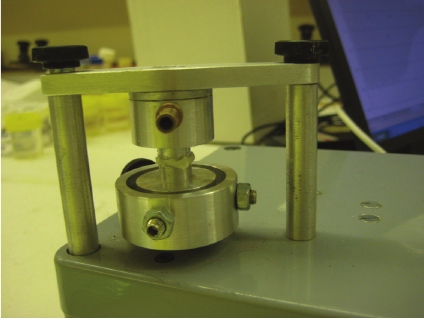
Figure 1: The custom made Wilson’s oscillating